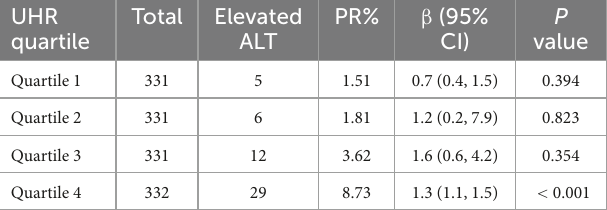
TABLE 4 Association between UHR quartiles and the prevalence of elevated ALT in patients. UHR Total Elevated quartile ALT